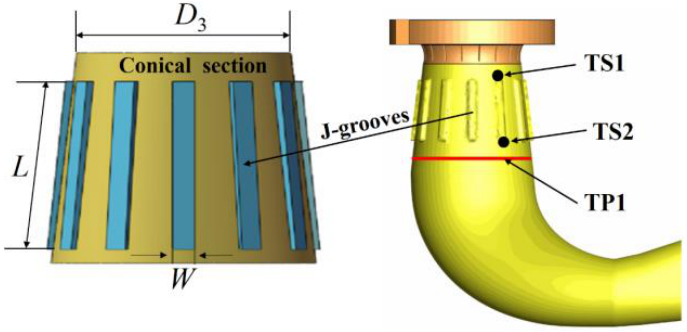
Figure 5. The layout of the J-grooves and the monitoring points and surface in the draft tube.